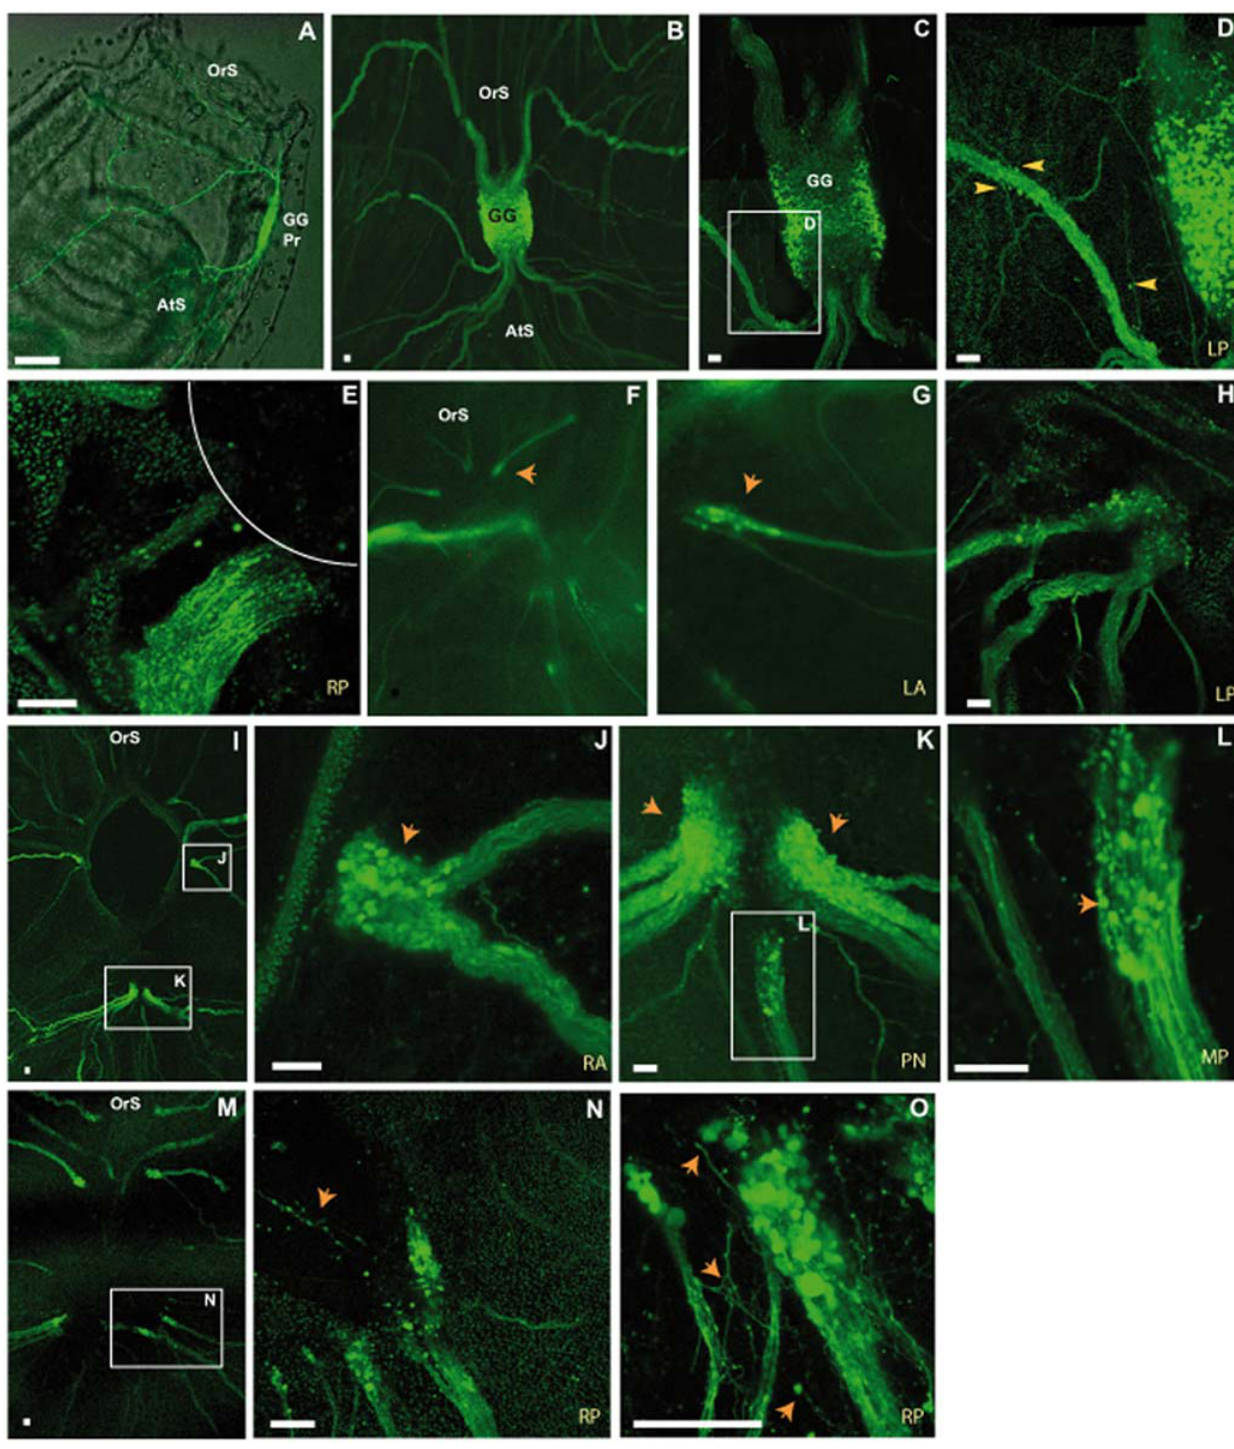
Figure 5. Cell masses arranged around nerve ends. Nerves visualized in E15 transgenic animals. GFP is produced only after the metamorphosis of juveniles ( A ). Ganglion and emerging nerves in B . Nerves in close proximity to the ganglion before ablation. C and D show peripheral cell bodies (yellow arrowheads). Nerve ending just after ablation in E , with line indicating hole. At 2 dpa (stage I) no clear pattern of nerve cell bodies is observed at the nerve endings ( F , G and H ). Nerve ending with cell bodies forming a swelling at 4 dpa ( I , arrowheads in J and arrowheads in K ). Some thickened nerve cell masses start to extend their axons toward the anterior at 4 dpa ( L ). At 9 dpa (early stage III) the nerve end cell masses decrease in size and send lots of extensions in the anterior and posterior directions, sometimes making connections ( M , arrowheads N , and O ). All scale bars, 50 m m. Ganglion primordium (GG Pr), atrial siphon (AtS), oral siphon (OtS), left posterior nerve (LP), right posterior nerve (RP), mid-posterior nerve (MP), posterior nerves (PN), right anterior nerve (RA) and left anterior nerve (LA). Fluorescent confocal images obtained with the Leica SP5 system (5 6 , 20 6 and 40 6 ).